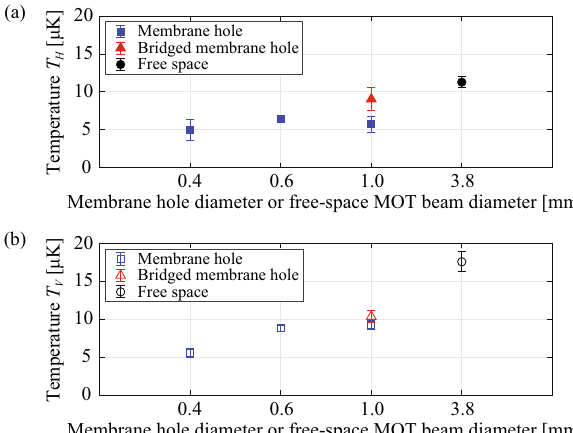
Figure 5. Sub-Doppler cooled temperature of MOT atoms versus membrane hole diameter or free-space MOT beam diameter. ( a ) Temperature T H , the temperature of atoms on the horizontal plane. ( b ) Temperature T V , the temperature of atoms along the vertical axis. For this, we performed a millisecond of polarization gradient cooling. We used 3.8 mm diameter beams ( d MOT ) for the free-space MOT (black circle) and 0.4, 0.6, 1.0 mm-diameter membrane holes ( d Hole ) for the membrane MOT (blue square) and the bridged membrane MOT (red triangle). The bridged membrane MOT experimentally simulates the situation of a 3- µ m-width membrane ridge waveguide across the membrane